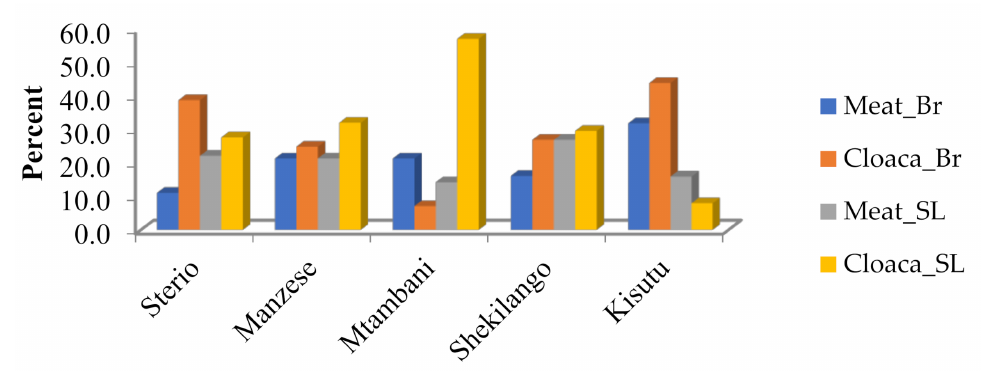
Figure 2. Multiple drug resistance of E. coli by location of poultry